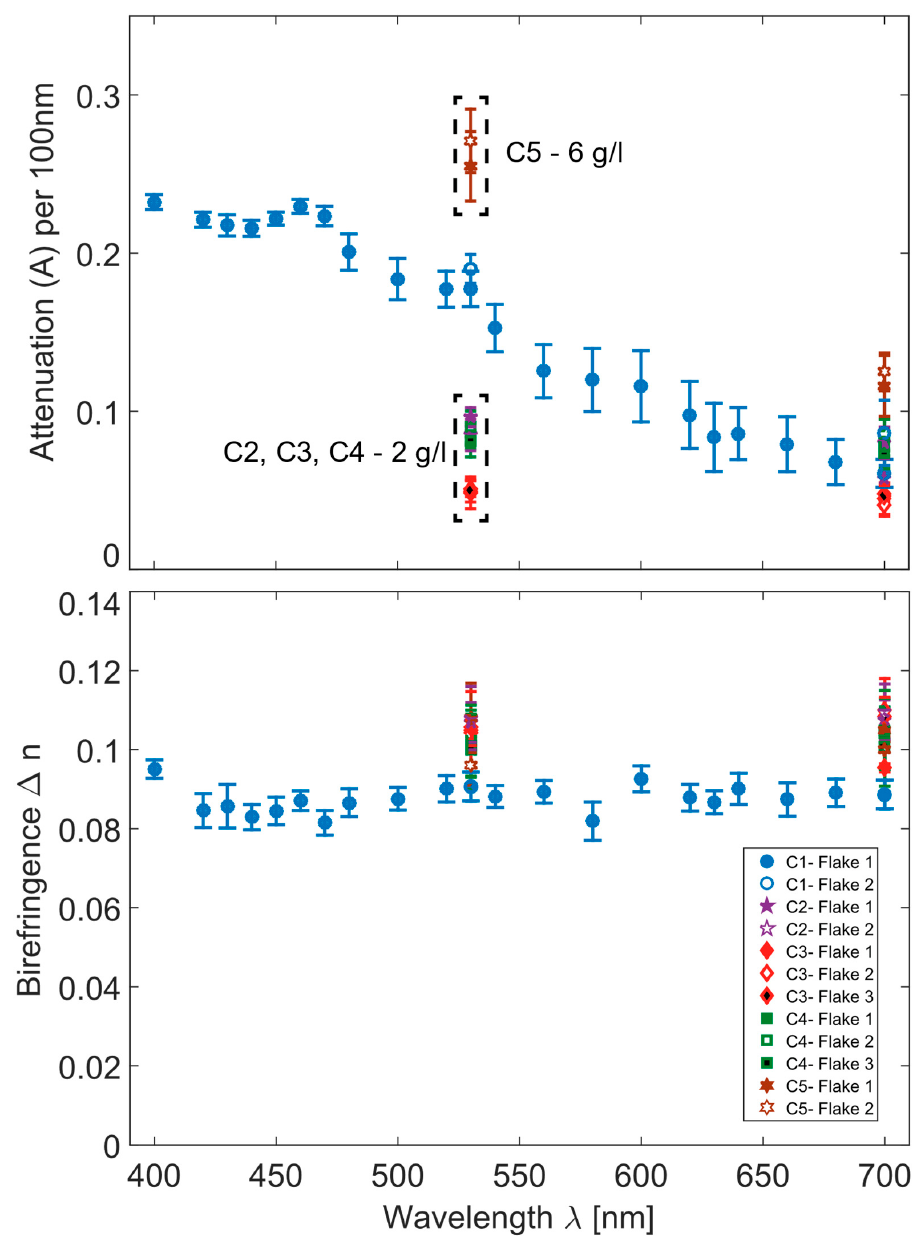
Figure 3. Experimental results for various flakes on di ff erent samples. The graphs contain data from our previous work [27] to serve as a reference (C1-Flake 1 and C1-Flake 2). The birefringence for flakes with di ff erent fabrications remain constant around ∆ n = 0.1. The attenuation is a ff ected by the concentration of the SMC used during the fabrication